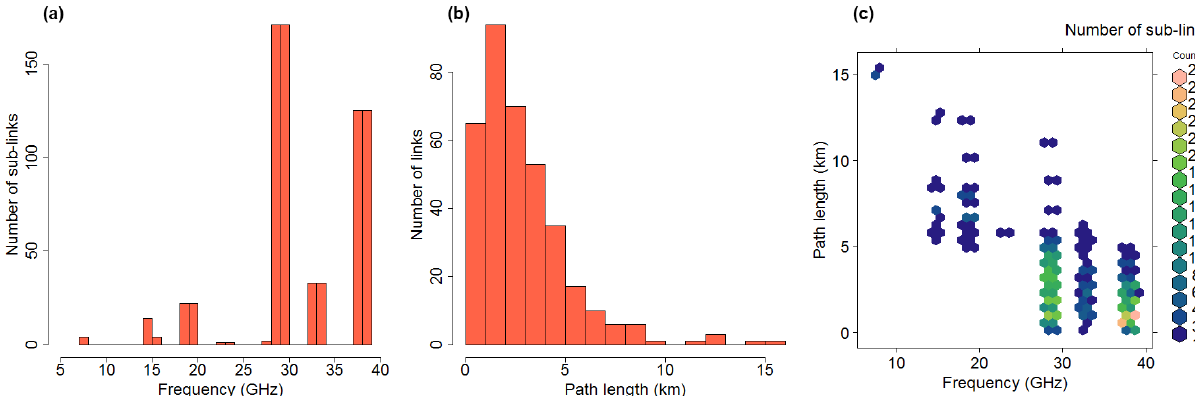
Figure 4. CML network characteristics. (a) Distribution of carrier frequencies. (b) Distribution of path lengths. (c) Relationship between path length, frequency, and number of sub-links.